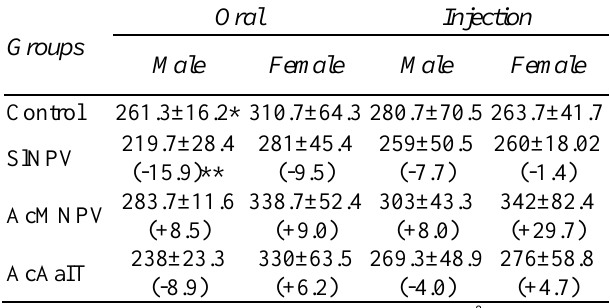
Table 6: Platelet numbers following oral or intraperitoneal injection treatment of rats with SlNPV, AcMNPV or AcAaIT.